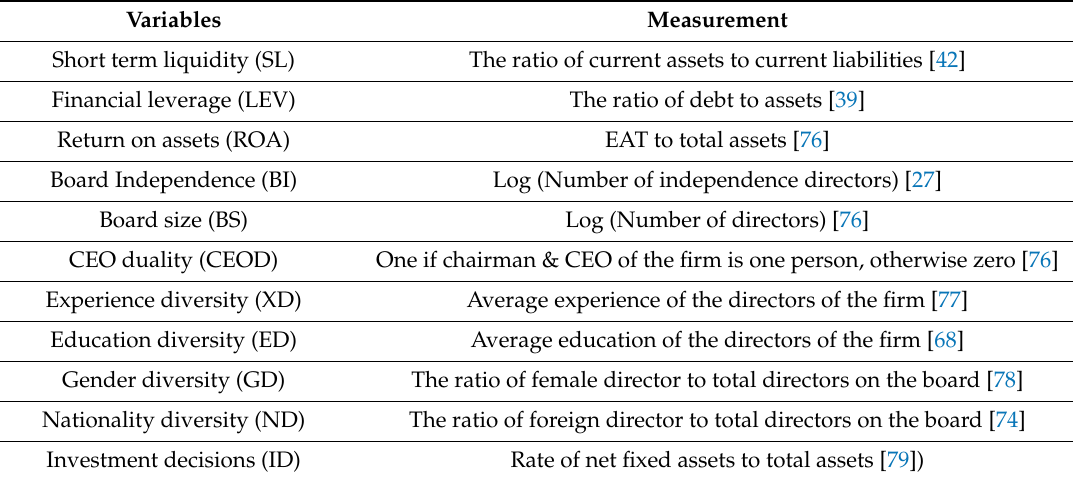
Table 1. Measurement of Variables.